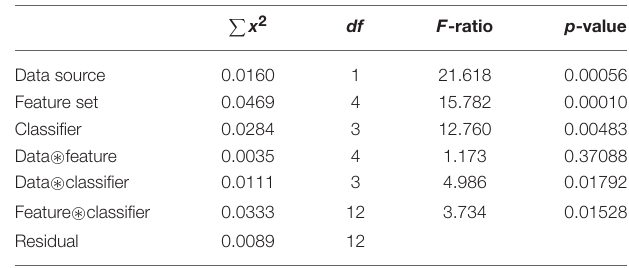
TABLE 6 | The results of the multivariate ANOVA test on the combined results of Tables 4 , 5